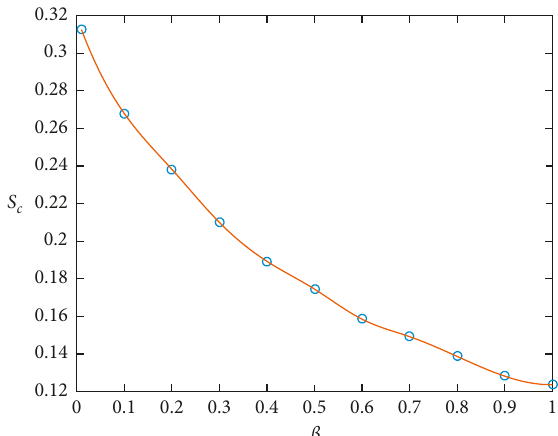
Figure 3: Critical bed friction numbers S α � 1.